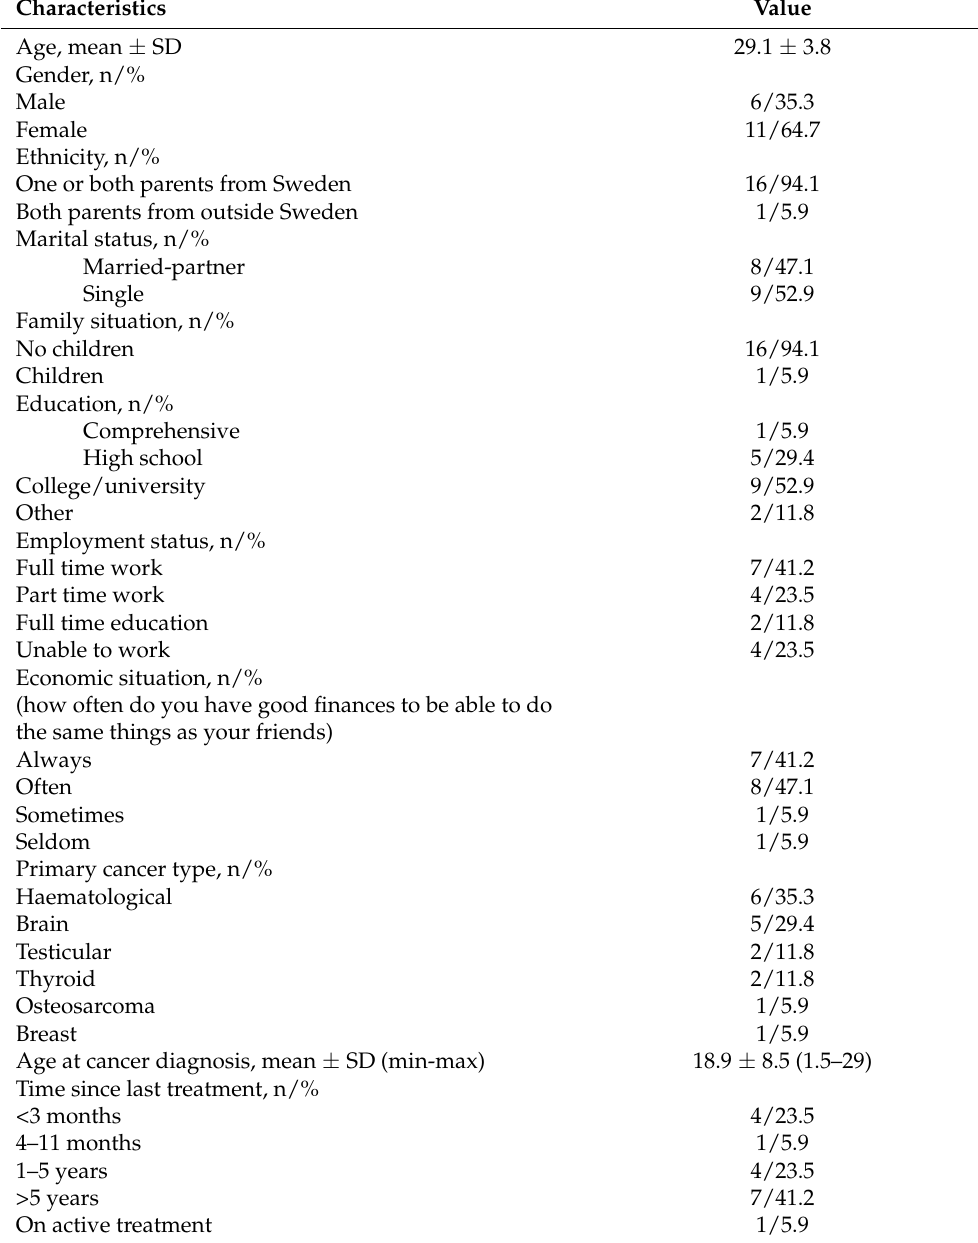
Table 2. Demographic characteristics of study participants ( n =